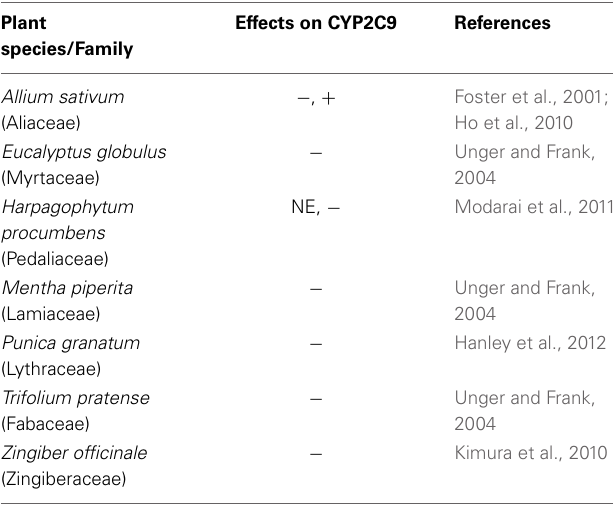
Table 2 | Medicinal plant species listed in RENISUS with reported effects of on